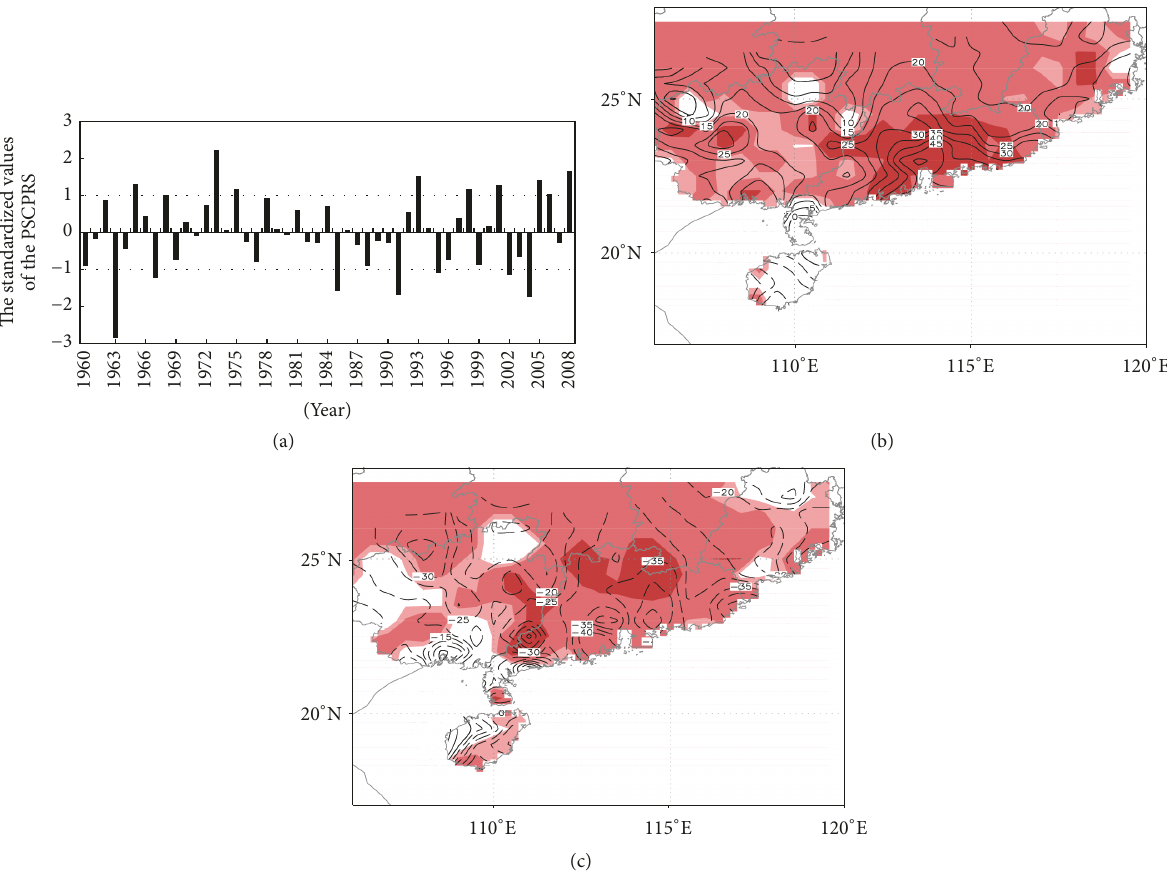
Figure 2: (a) Standardized values of the PSCPRS. Composite distributions of the PSCPRS in flood years (b) and drought years (c). Significant values exceeding the 90%, 95%, and 99% confidence levels ( 𝑡 -test) are